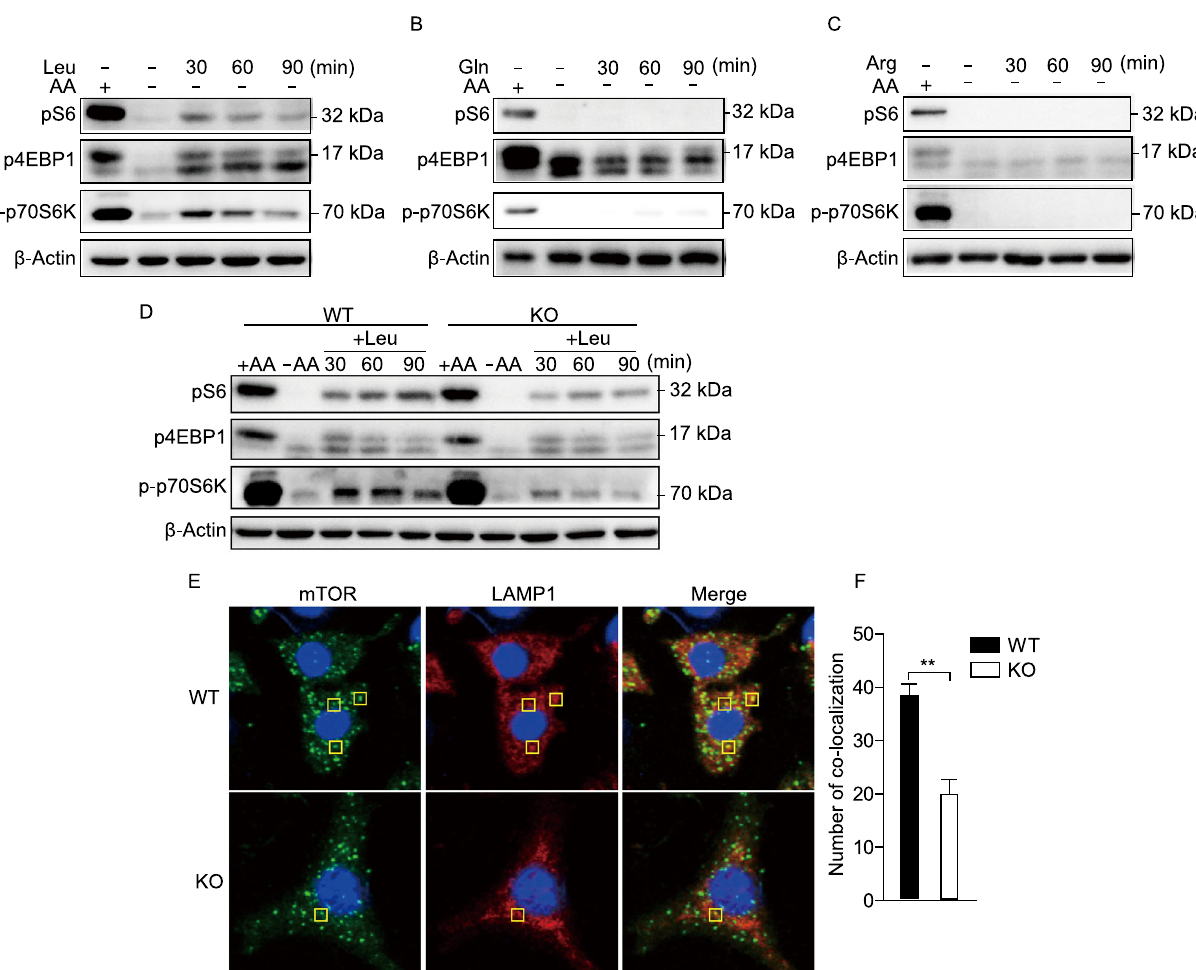
Figure 1. Leucine, but not glutamine and arginine, induces mTORC1 activation in macrophages . BMDMs were starved with DMEM medium containing no amino acids and FBS for 2 h, followed with stimulation with medium containing AAs or 4 mmol/L leucine (A), 20 mmol/L glutamine (B), and 2 mmol/L arginine (C) for the indicated times. Phosphorylation S6, 4E-BP1, p70S6K, and β -actin were determined by immunoblotting analysis. (D) Wild type and Atp6v0d2 − / − BMDMs were starved with DMEM medium containing no amino acids and FBS for 2 h, followed with stimulation with DMEM containing 4 mmol/L leucine for the indicated times. Phosphorylation S6, 4EBP1, p70S6K, and β -actin were determined by immunoblotting. (E) Wild type and Atp6v0d2 − / − BMDMs were starved with DMEM medium containing no amino acids and FBS for 2 h, followed with stimulation with medium containing 4 mmol/L leucine for 30 min. Lysosomes were visualized by immunostaining with antibodies to LAMP-1, nuclei were visualized by DAPI, and mTOR was visualized by immunostaining with antibodies to mTOR. Quadrilaterals indicate co-localization of LAMP1 and mTOR. (F) The numbers of co-localizations of LAMP1 with mTOR in 5 fi elds of view were quanti fi ed. Data shown are representative of